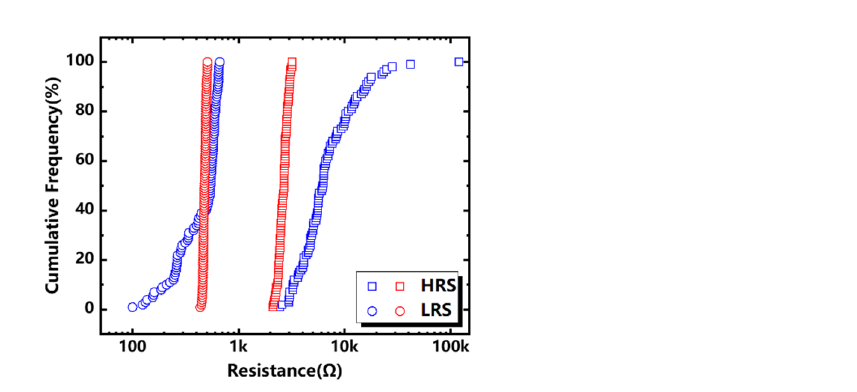
Figure 4. Distribution of HRS and LRS for the undoped (blue) and locally-doped Al ion devices (red) after 100 cycles of scanning.